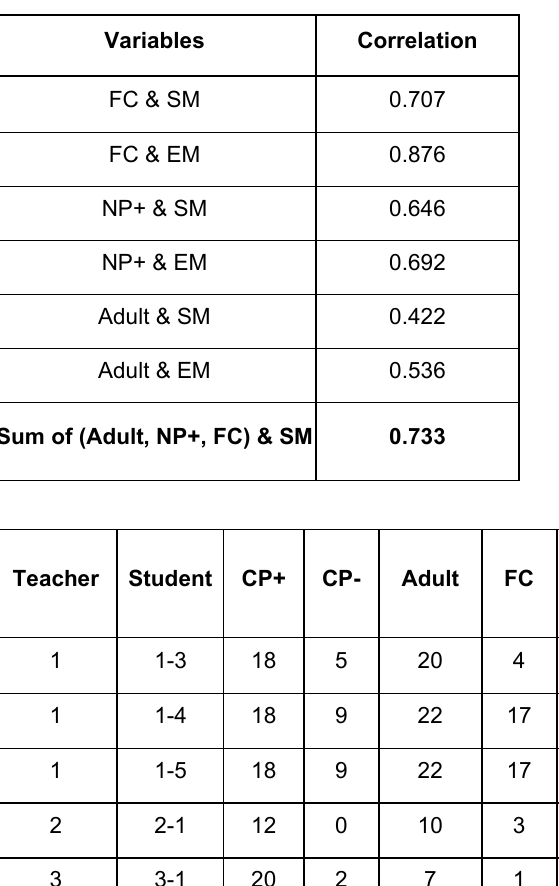
Table 2: Correlation between different variables in this study.